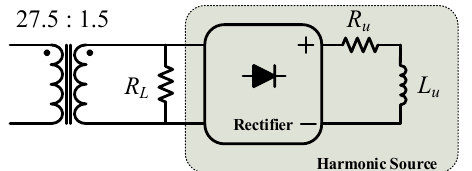
Figure 2. Electric model of an electric locomotive (based on [5]